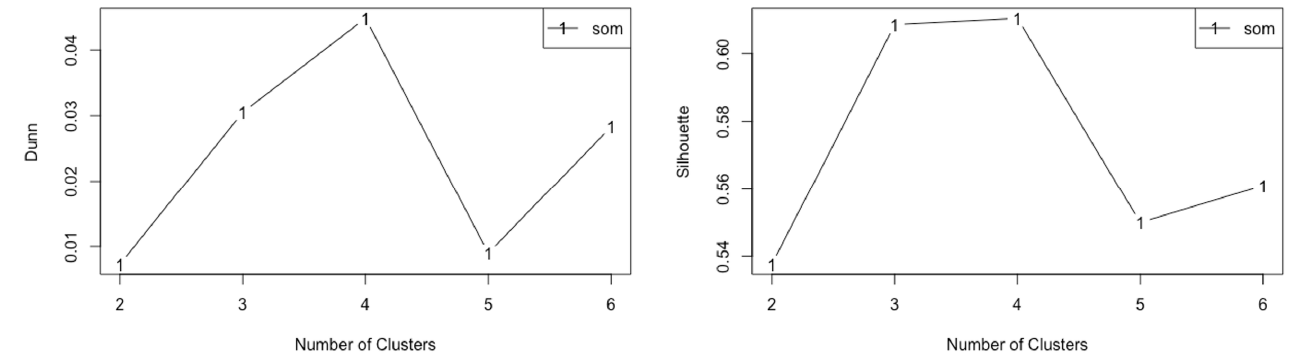
Figure 6. Dunn Index ( left ) and Silhouette Width ( right ) cluster validation for 2 to 6 clusters using self-organising maps algorithm.